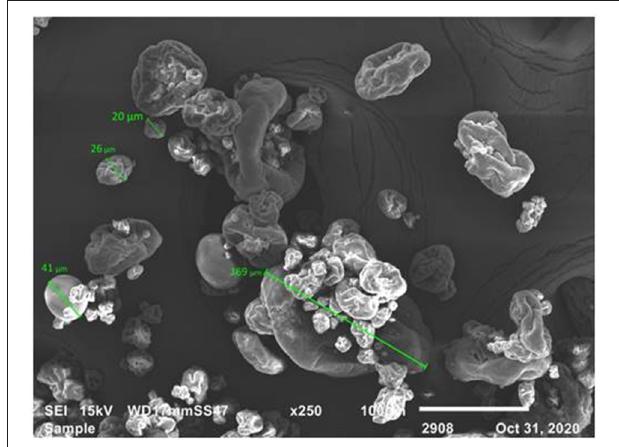
FIGURE 4 | SEM micrograph of the yeast cell wall fraction (YCW). Scale bar = 100 µ m.